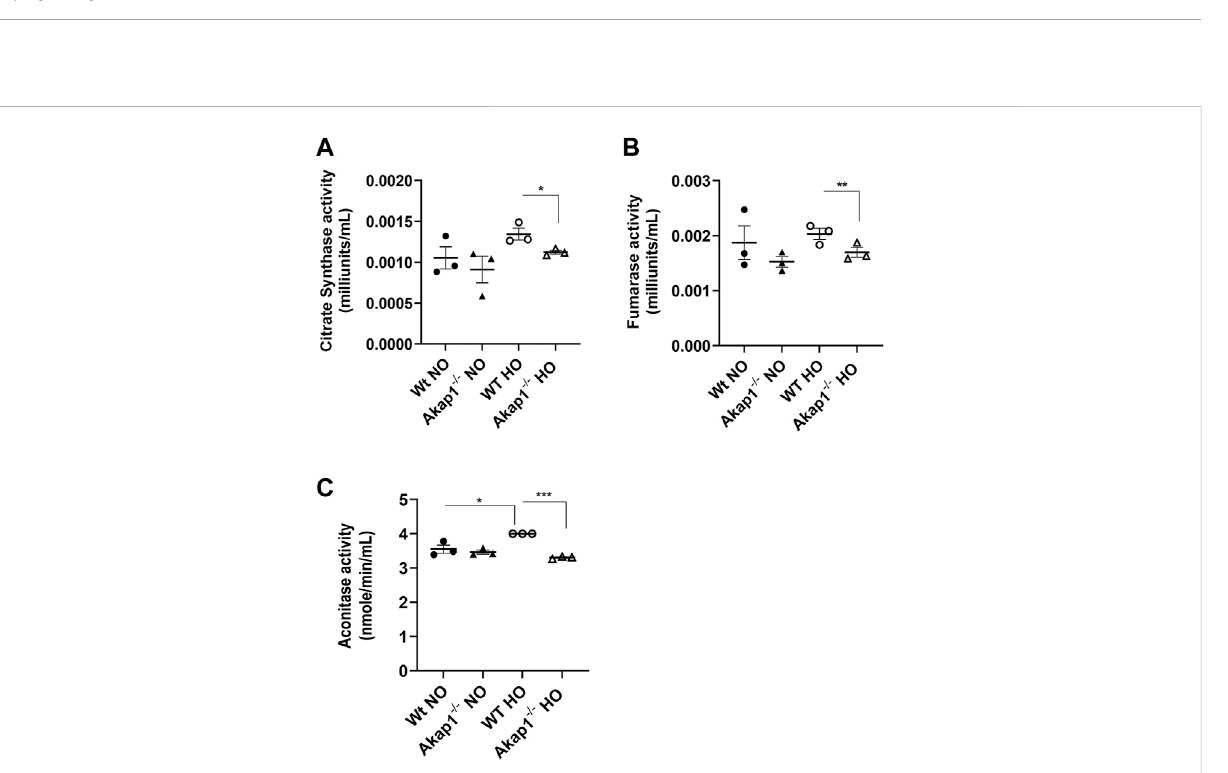
FIGURE 2 Decrease in mitochondrial enzymatic activities in Akap1 − / − mice exposed to hyperoxia. (A) Citrate synthase activity (milliunits/mL) in the mitochondrial lysates from Wt and Akap1 − / − mice exposed to normoxia or hyperoxia, respectively. (B) Fumarase activity (milliunits/mL) in mitochondrial lysates from Wt and Akap1 − / − mice exposed to normoxia or hyperoxia, respectively. (C) Aconitase activity (milliunits/mL) in the mitochondrial lysates from Wt and Akap1 − / − mice exposed to normoxia or hyperoxia. Data represented as mean ± SEM. Two-way ANOVA was used for analysis. * p < 0.05 Akap1 − / − hyperoxia versus Wt hyperoxia control. ** p < 0.01 Akap1 − / − hyperoxia versus Wt hyperoxia control. *** p